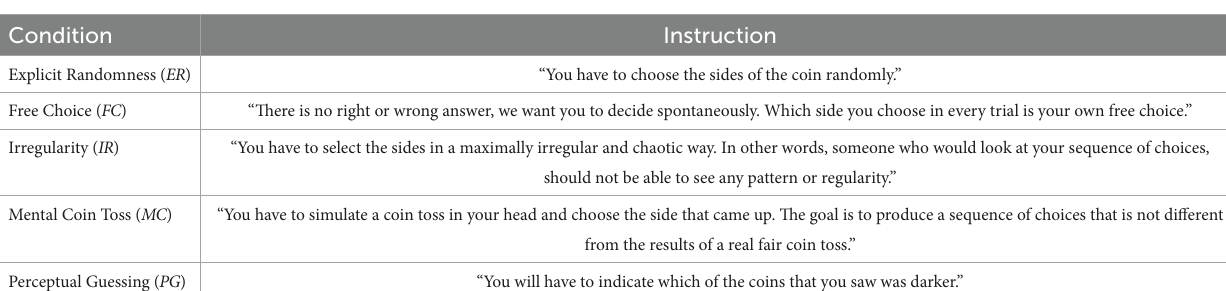
TABLE 1 Wording of